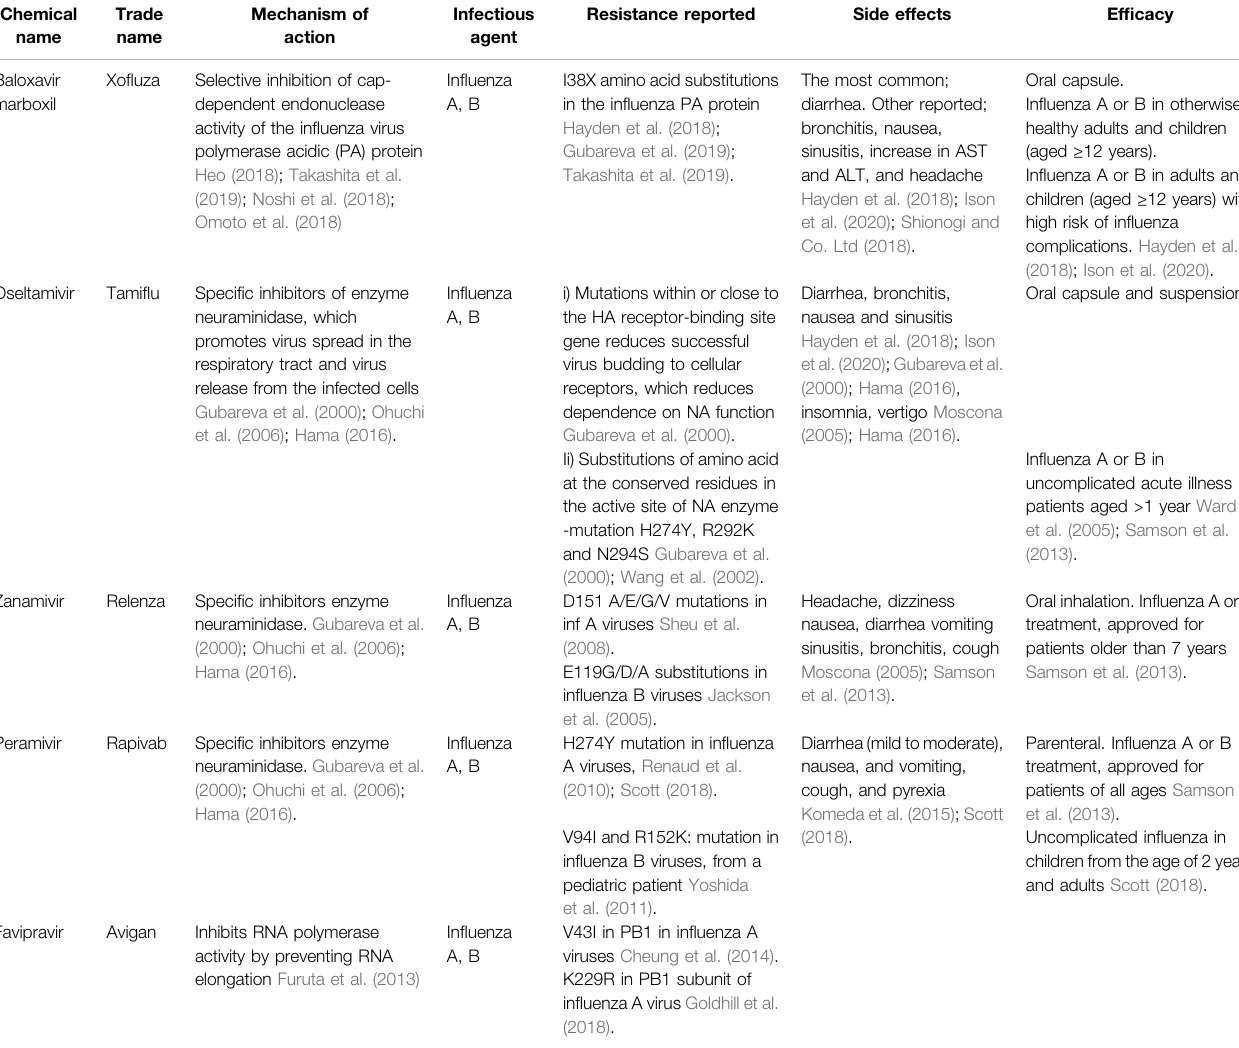
TABLE 1 | Anti-Viral medications for the treatment of In fl uenza A